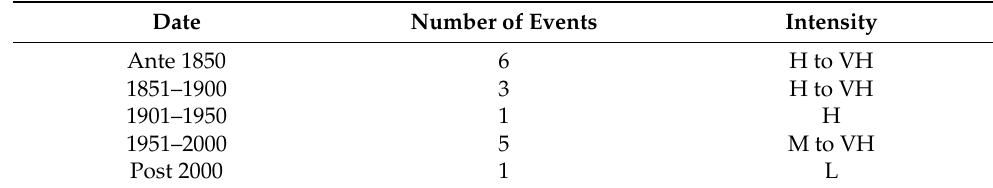
Table 1. Main flood associated to intense sediment transport, debris flow and hydrogeological processes occurred in the Ischiator catchment, organized per 50 years periods. For any period, a level of severity was assigned (low = L, medium = M, high = H and very high = VH) based on all available documentary information [58,59]. Details for all events can be found in the Table A1.